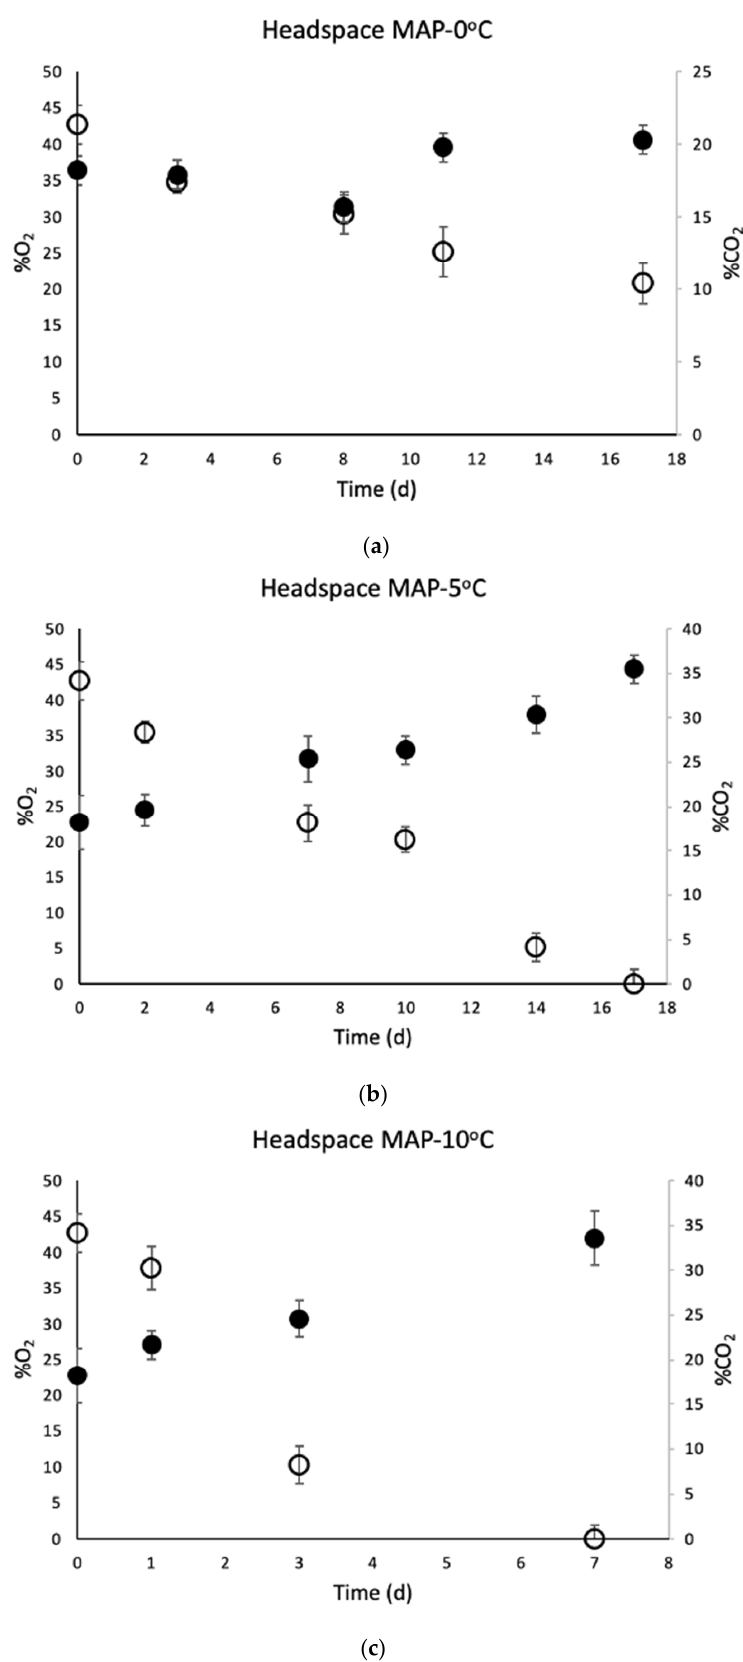
Figure 4. Concentration (%) of ○ O 2 and ● CO 2 in the headspace of MAP chicken stored at ( a ) 0 °C, O 2 and • CO 2 in the headspace of MAP chicken stored at ( a ) 0 ◦ C, ( b ) 5 °C, and ( c ) 10 °C. (cid:35) ( b ) 5 ◦ C, and ( c ) 10 ◦